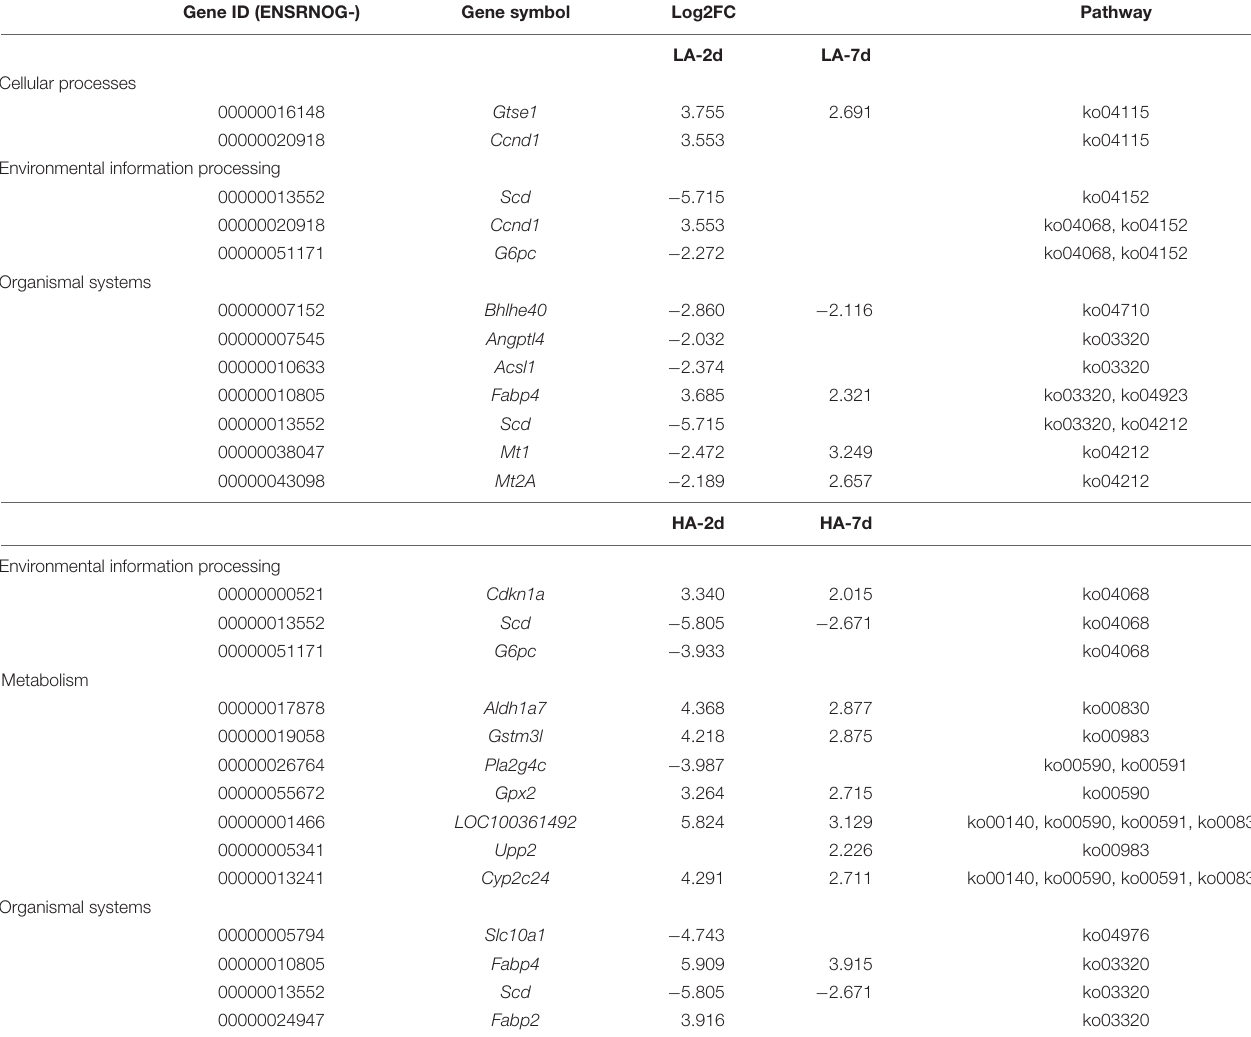
TABLE 5 | Effects of AESE duration on DEGs enrichment pathway and expression. Gene ID (ENSRNOG-) Gene symbol Log2FC